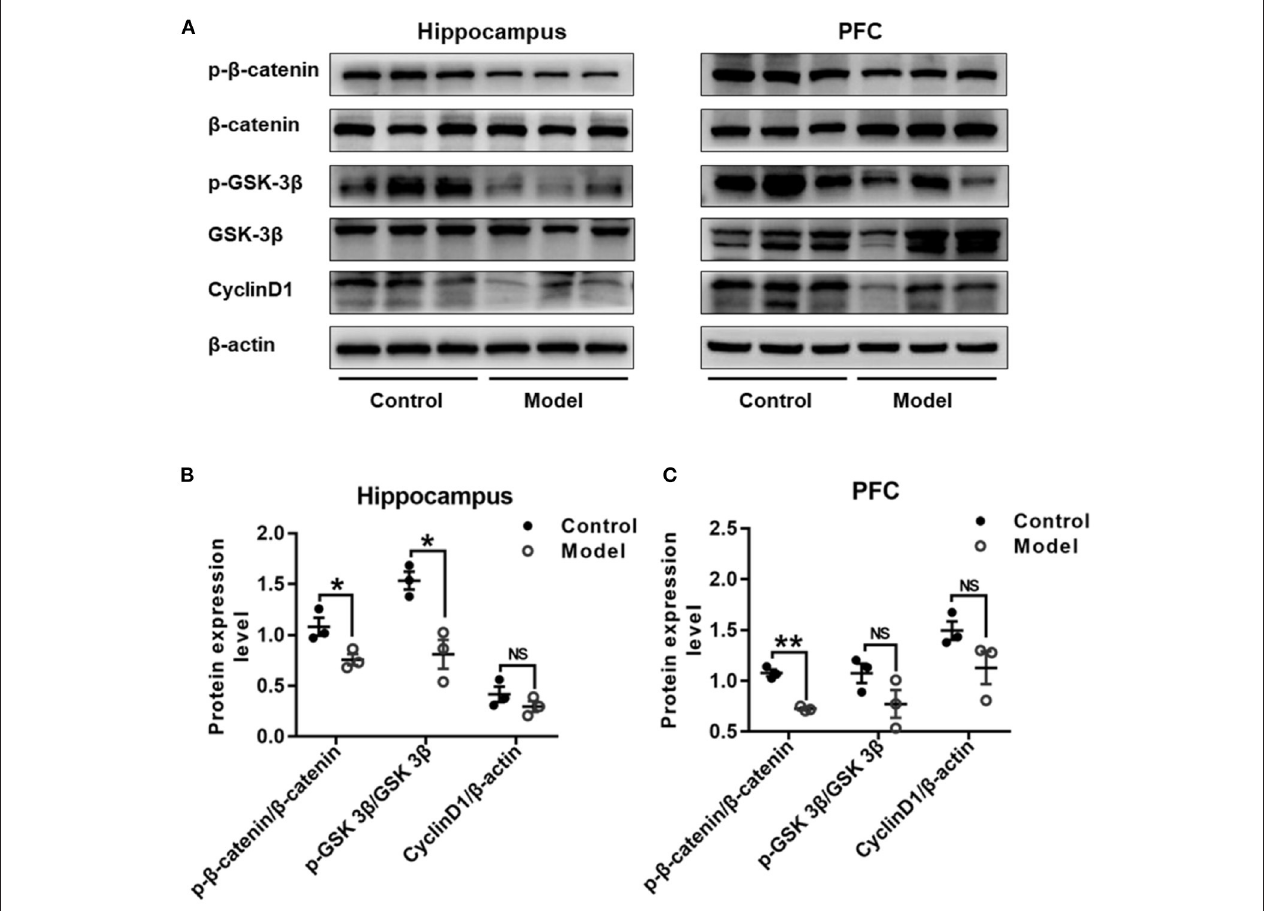
FIGURE 9 | Effect of bilaterally hippocampal injection of STZ on the key protein expression of Wnt/ β -catenin pathway in the hippocampus and prefrontal cortex of model mice. Typical graph (A) and statistical analyses (B,C) of the western blot results. Data in (B,C) are presented as the mean ± SEM ( n = 3 for each group). In the hippocampus (A,B) , the expression of p- β -catenin/ β -catenin and p-GSK-3 β (ser9)/GSK-3 β was decreased in the model group, without CyclinD1. In PFC (A,C) , although the expression of p- β -catenin/ β -catenin of model mice was lesser than that of control mice, but not p-GSK-3 β (ser9)/GSK-3 β and CyclinD1. * P < 0.05, ** P < 0.01; compared with the control group, NS is no